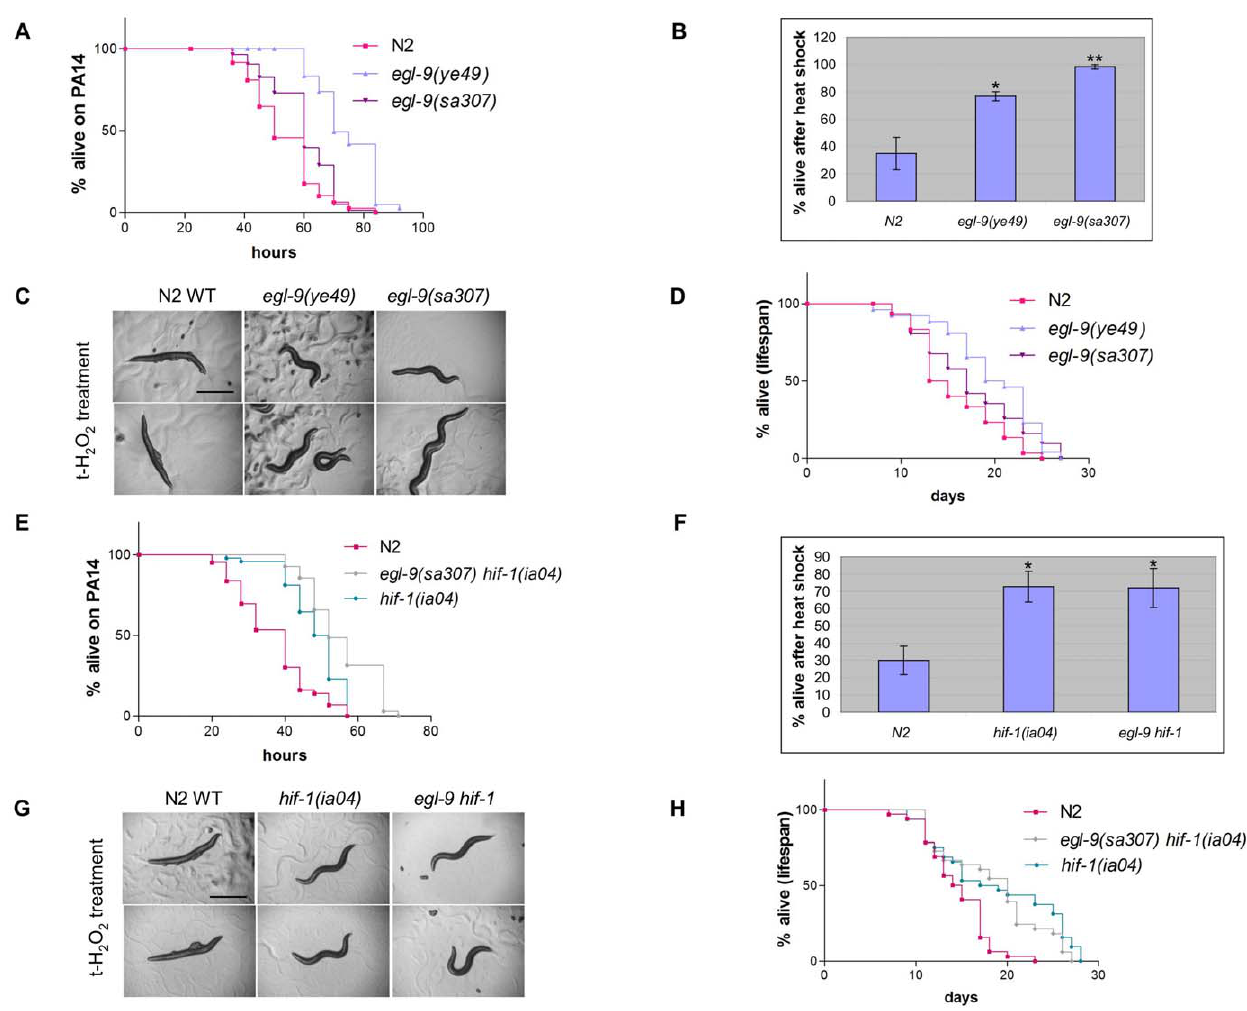
Figure 4. egl-9 and hif-1 mutant phenotypes on other stressors and on aging. (A) The survival of wild-type N2 and egl-9 mutant animals on P. aeruginosa PA14 are shown for one representative assay (n . 50). (B) egl-9 mutant and N2 animals were scored for viability after 12 h exposure to 35 u C. Data are averaged from three independent experiments with n . 30 for each. Error bars represent standard error of the mean, * represents P values , 0.05 and ** P values , 0.01. (C) Comparison of egl-9 mutant animals to wild-type animals on hydrogen peroxide. Representative worms are shown for each strain 6 h after continual treatment. Wild-type N2 animals are still alive but paralyzed, whereas egl-9 mutant animals are active and healthy, indicative of resistance. (D) Lifespan of N2 and egl-9 mutants feeding on E. coli OP50 (n . 30 animals per strain). One of three representative experiments shown. (E–G) hif-1(ia04) and egl-9(sa307) hif-1(ia04) mutant animals challenged with (E) P. aeruginosa PA14 (one of three representative experiments shown), (F) heat shock at 35 u C for 14 h, and (G) oxidative stress (hydrogen peroxide; both mutant strains are still active, unlike N2 animals). (H) Lifespan of hif-1(ia04) and egl-9(sa307) hif-1(ia04) mutant animals feeding on E. coli OP50. Quantitative data and statistical analyses for the experiments shown here are included in Table 2. Independent repeats for the PA14 and lifespan assays are shown in Table